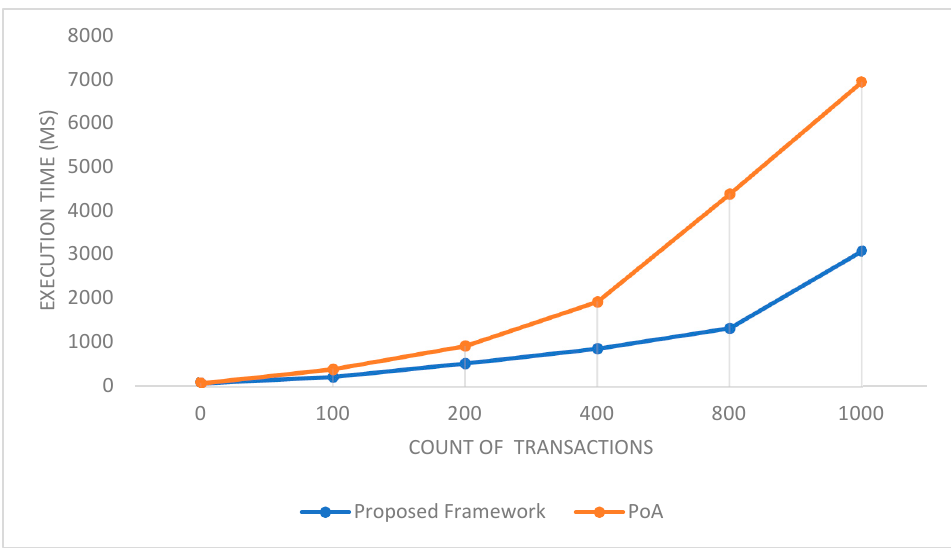
Figure 15. Average execution time of the proposed framework compared with PoA.